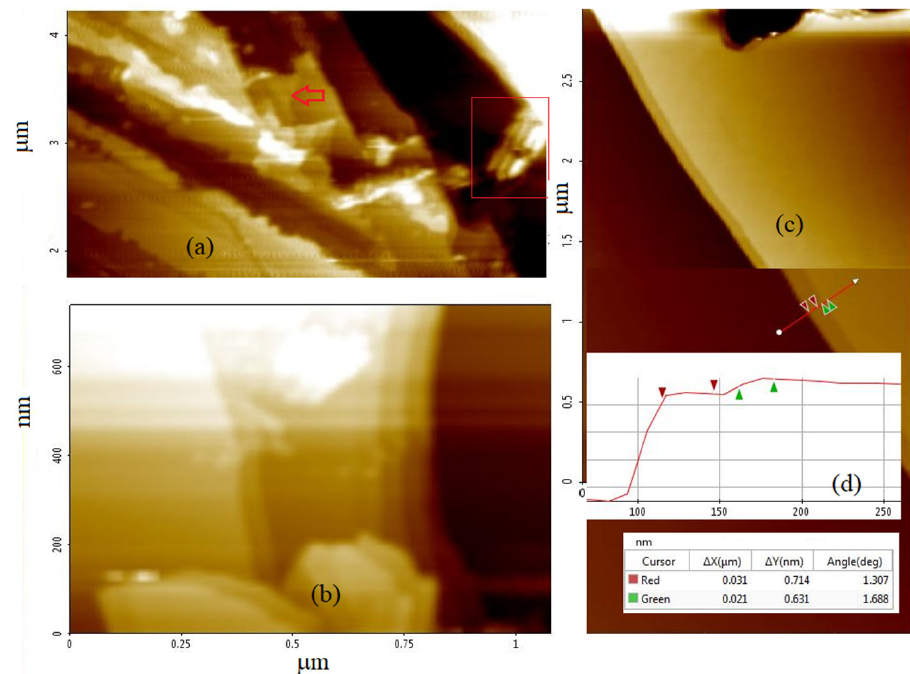
Figure 7. AFM images after dip coating onto mica and rinsing with deionized water: ( a ) representa- tive topographic selected height image of graphene flakes with clear edges ( b ) two to three layers FLG stacking, ( c ) surface of two-layered graphene, ( d ) height profile of the regions marked by red and blue color, demonstrating the different thickness of graphene layers.